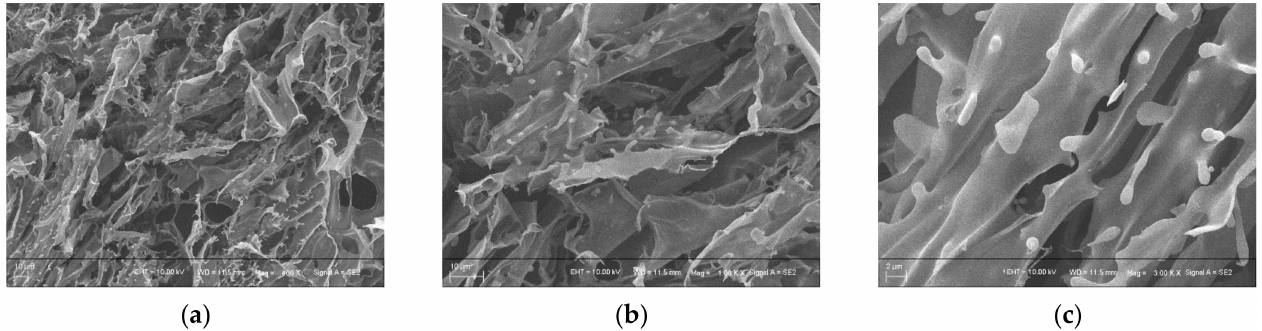
Figure 5. Scanning electron micrographs of purified aggregated M-EPS polymer at three magnifica- tions. ( a ) 400 × , ( b ) 1000 × , ( c ) 3000 ×